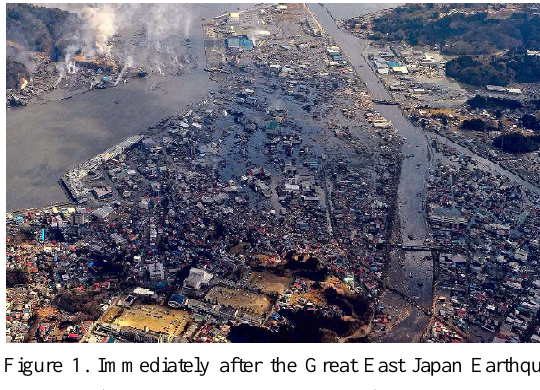
Figure 1. Immediately after the Great East Japan Earthquake (Near Kesenuma, Miyagi